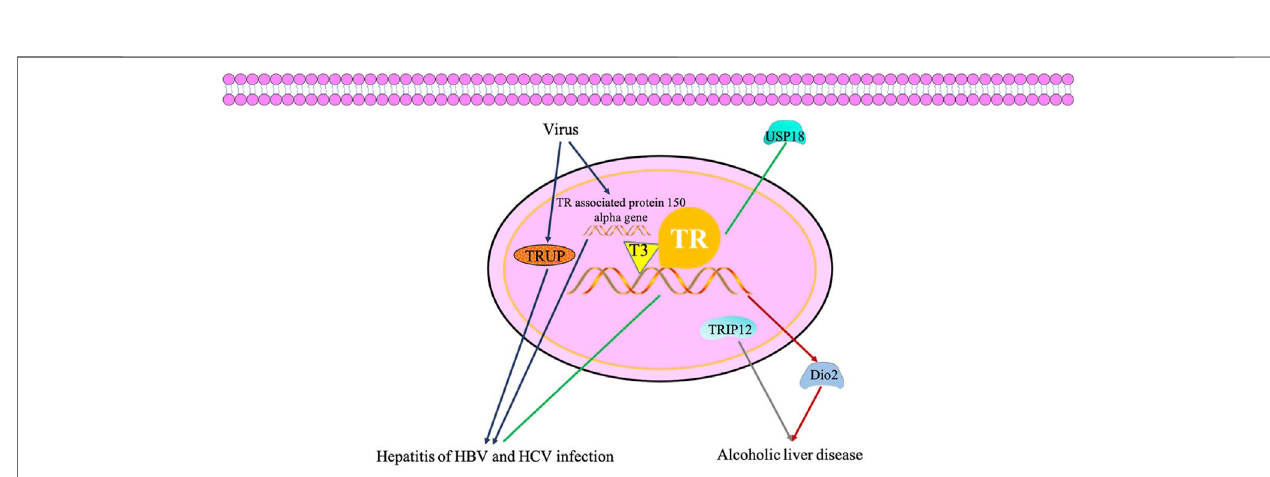
FIGURE 4 | TH/TR axis may be involved in hepatitis of hepatitis B virus and hepatitis C virus infection and accelerates alcoholic liver disease. USP18 regulates the signaling of antivirus by the thyroid hormone signaling pathway. TRUP gene and thyroid hormone receptor associated protein 150 alpha gene are associated to the integrationofHBVDNAintothelivercellDNA,whicharekeyregulatorsofcellproliferationandviability.THhasbeenproventoincreasethelevelofDio2,therebyelevating susceptibility to hepatic steatosis in a model of alcoholism. The mRNA level of TRIP12 is signi fi cantly different in alcohol liver disease.